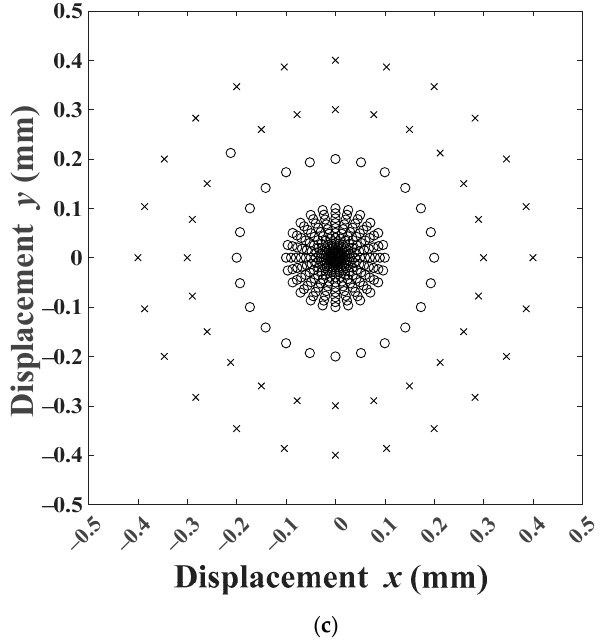
=ω =ρ =ω =ρ 0.08 mm and 100 0.08 mm and 100